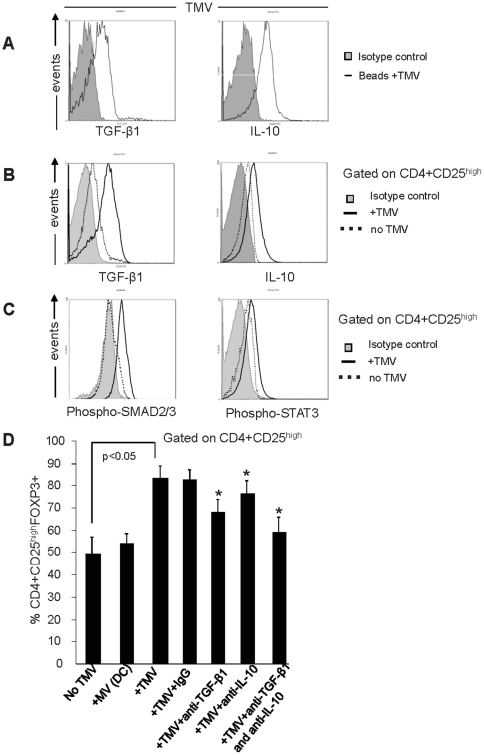
TMV-associated TGF-β1 and IL-10 promote Treg expansion.(A) Flow cytometry analysis of TGF-β1 and IL-10 expression on TMV purified from OVCAR-3 SN and coated onto latex beads. (B) CD4+CD25highFOXP3+ T cells were cultured with OKT3, anti-CD28 and IL-2 (150 IU/mL) +/− TMV for 72 h at 37°C in the presence of Golgistop and then stained for CD4, CD3, CD25 and intracellular TGF-β1 and IL-10. Expression of both cytokines was up-regulated in the presence of TMV (p<0.05). (C) SMAD2/3 and STAT3 phosphorylation in Treg before and after exposure to TMV. Representative results are from one of three independent experiments for A, B and C. (D) The percentage of CD4+CD25highFOXP3+ T cells increased among CD4+CD25+ T cells cultured in the presence of TMV but not DC-derived MV. Neutralizing anti-TGF-β1 and/or anti-IL-10 Abs inhibited the induction of Treg by TMV. Non-blocking IgG isotype control Abs were used as controls. Asterisks indicate decreases (p<0.05) in Treg percentages in the presence of neutralizing Abs. Results are means ± SD of three independent experiments.